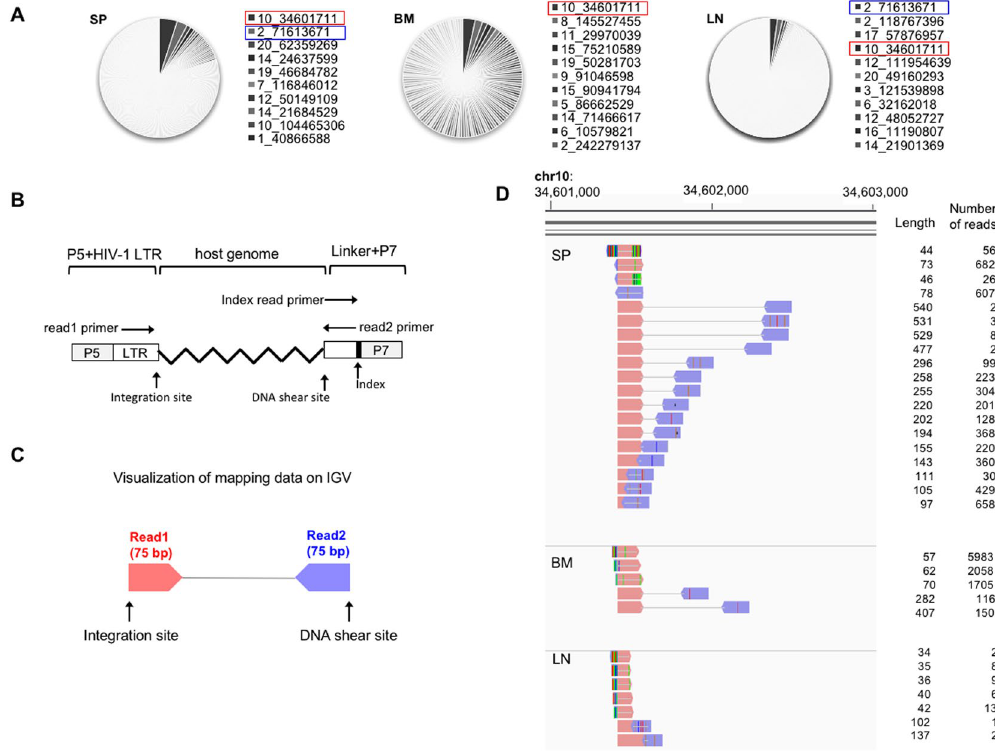
Figure 6. Evidence of systemic expansion of HIV-1-infected clones. ( A ) Pie charts of the abundance of HIV-1- infected clones in the mouse no. 5 shown in Fig. 3B. Red rectangles highlight a highly expanded clone detected in SP, BM, and LN. Blue rectangles highlight a highly expanded clone in SP and LN (Supplementary Fig. S7). ( B ) Schematic diagram to show the positions of each primer used for Illumina sequencing. ( C ) Schematic diagram for visualizing mapped data on IGV software. ( D ) Visualization of sequencing data of an expanded clone detected in all tissues analyzed. The length between the integration site and the DNA shear site is shown on the right side of each amplicon. The number of reads is also shown on the right side of each